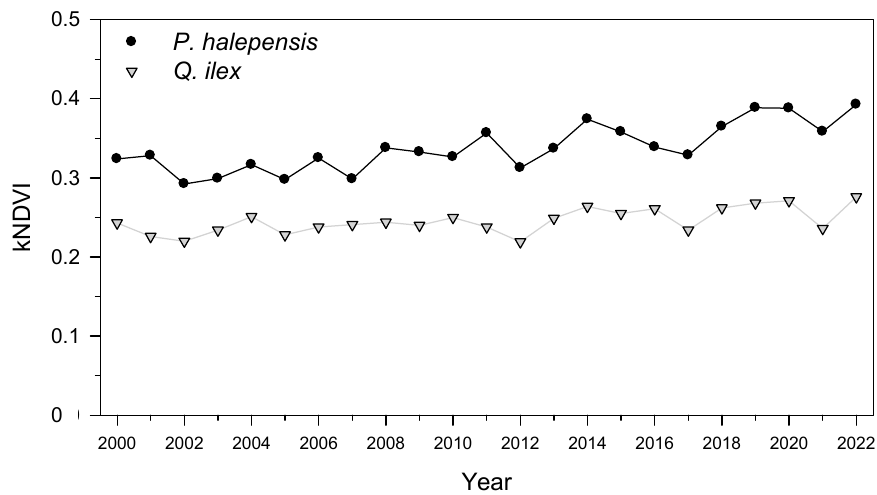
Figure 3. kNDVI annual values (period 2000–2022) estimated for areas with damage after the 2021 cold spell and dominated by P. halepensis and Q. ilex .